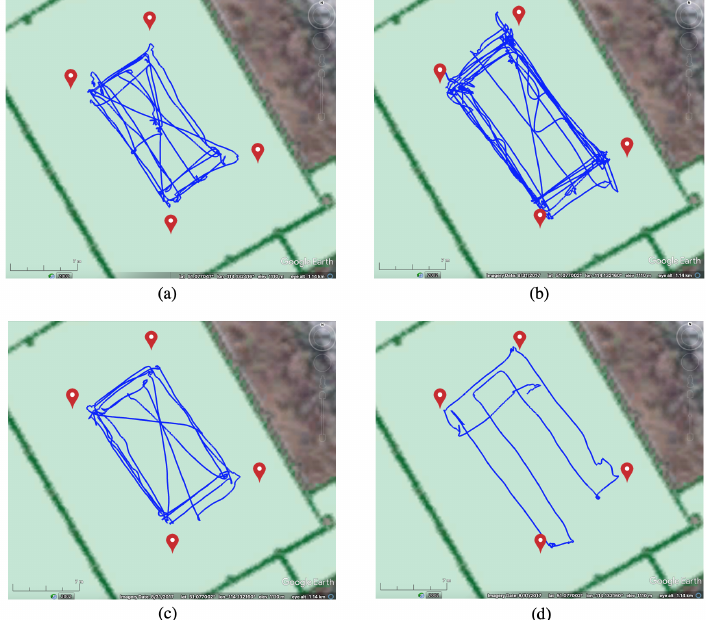
Figure 3. Test trajectories: ( a ) Trajectory 1; ( b ) Trajectory 2; ( c ) Trajectory 3; ( d ) Trajectory